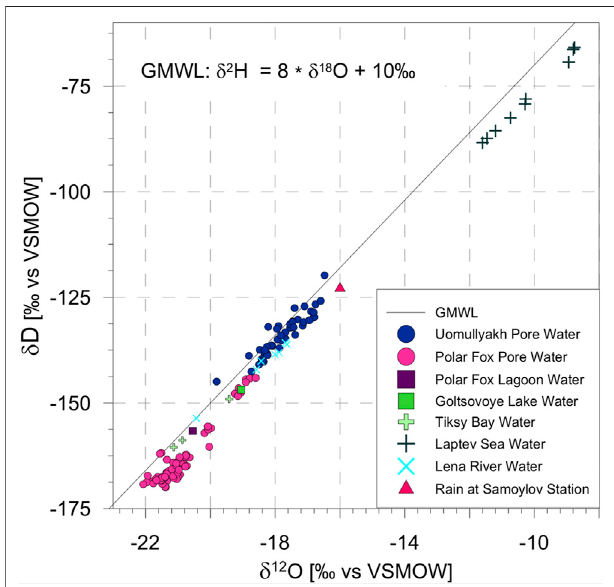
FIGURE 7 | Comparison of the stable water isotope composition of lagoon core pore water and surface water of different possible endmember; sediment pore water from April 2017 (this study); water of Polar Fox Lagoon, GoltsovoyeLake, andTiksiBayweresampled inJuly2017(P.Overduin, unpublished data); Laptev Sea water was sampled during expedition with the research vessel Pavel Bashmakov at the end of August 2002 (H. Meyer, unpublished data); Lena River water from summer 2005 – 2016 (clustered points)andonesamplefromApril2013(isolatedpoint)(H.Meyer,unpublished data). Stable water isotopes δ D and δ 18 O relative to Vienna Standard Mean Ocean Water (VSMOW).